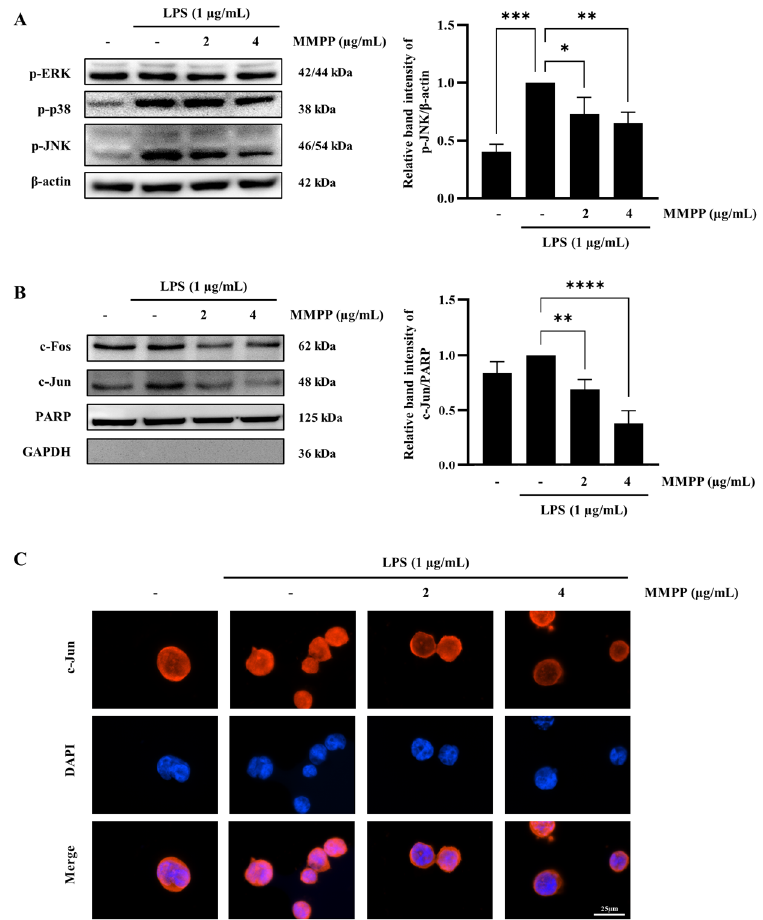
Figure 4. Inhibitory effects of MMPP on the expression of MAPKs and AP-1 in LPS-stimulated THP-1 cells. THP-1 cells were pretreated with MMPP (2 and 4 µ g/mL) for 1 h and treated with LPS (1 µ g/mL) for 60 min ( A ) and 90 min ( B , C ). ( A ) The phosphorylation levels of MAPKs were evaluated by Western blot. The relative band intensities of p-JNK to β -actin were evaluated by ImageJ software. Data are presented as the mean ± SD ( n = 3); * p < 0.05, ** p < 0.01, and *** p < 0.001 by one-way ANOVA. ( B ) The nuclear translocations of c-Fos and c-Jun were evaluated by Western blot. PARP and GAPDH were used as positive and negative controls, respectively, for the nuclear and cytosolic fractions. The relative band intensities of c-Jun to PARP were evaluated by ImageJ software. Data are presented as the mean ± SD ( n = 3); ** p < 0.01, and **** p < 0.0001 by one-way ANOVA. ( C ) The nuclear translocation of c-Jun was evaluated by immunofluorescence staining, c-Jun was labeled with Cy3 (red) in cells, and nuclei were labeled with DAPI (blue). Scale bar = 25 µ